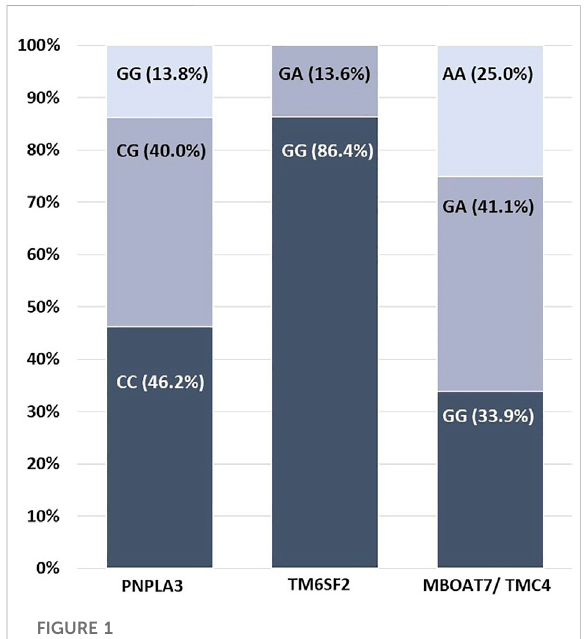
FIGURE 1 Distribution of allele variants for each gene